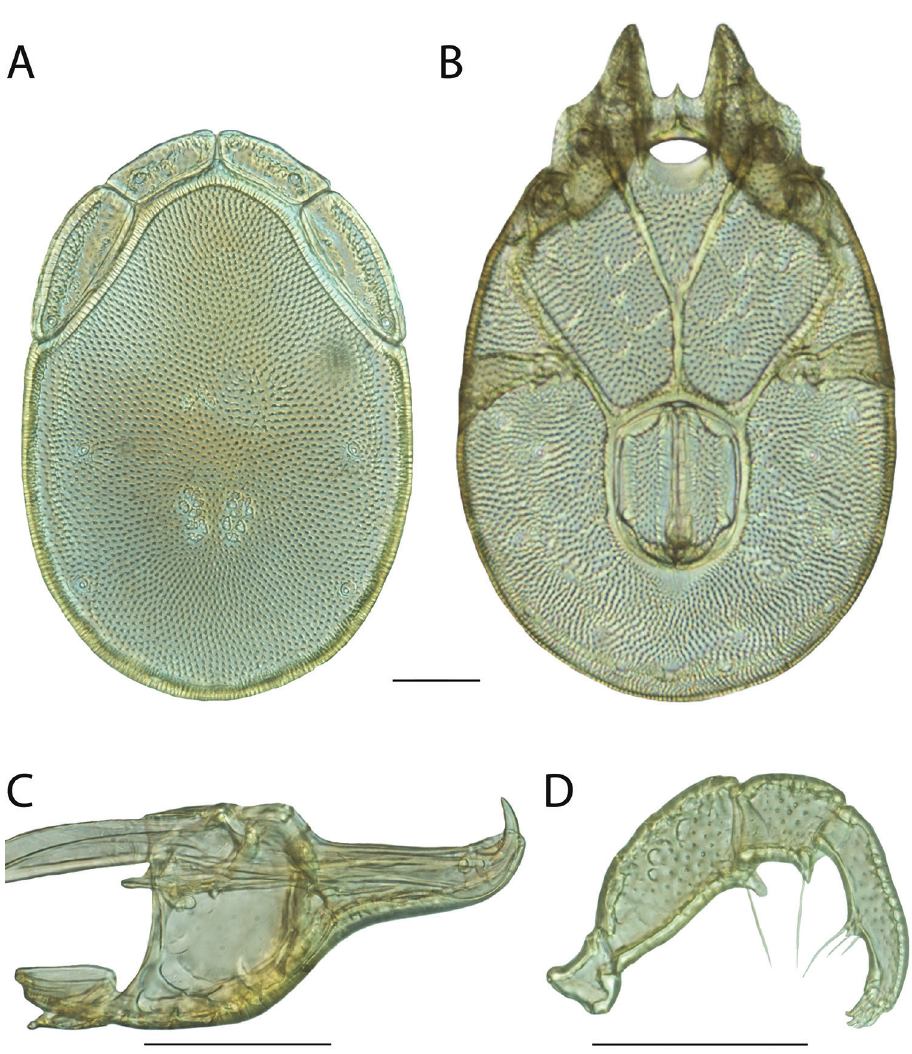
Figure 236. Torrenticola sharkeyi sp. n. male: A dorsal plates B venter (legs removed) C subcapitulum D pedipalp (setae not accurately depicted). Scale = 100